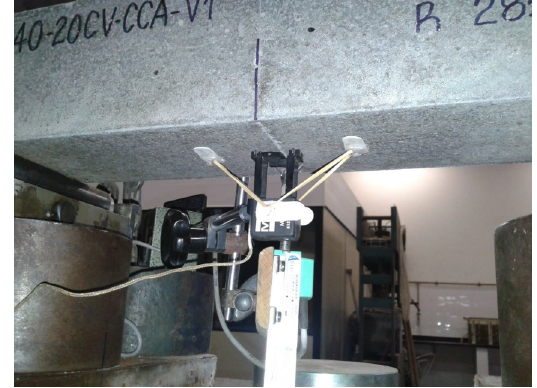
Figure 1. Clip Gauge placement detail for CMOD reading.